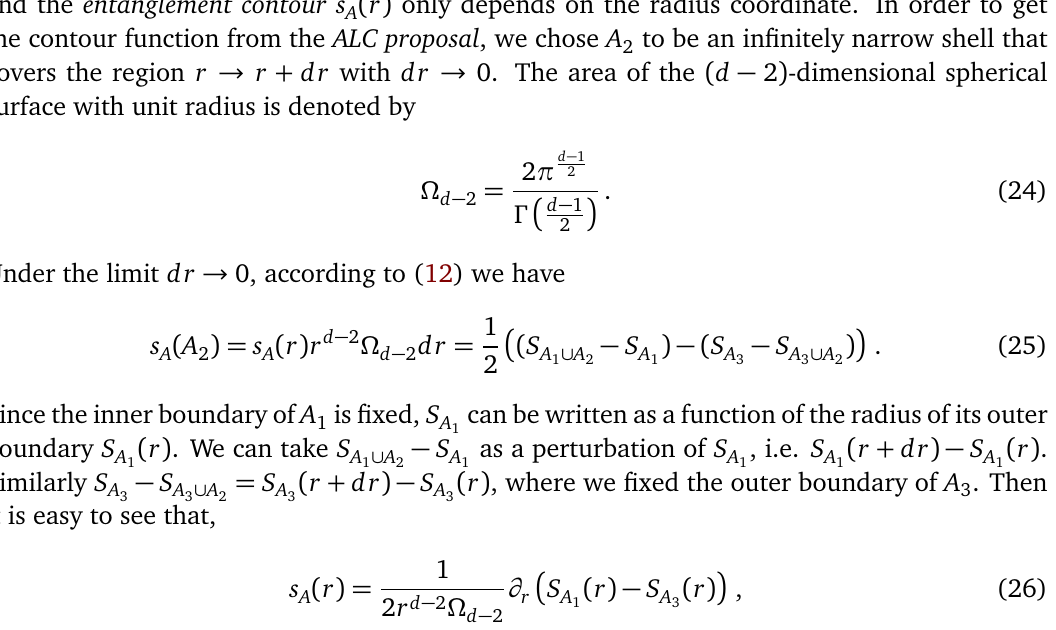
Figure 5: In the above figure we set A = A and outer radio is R purple